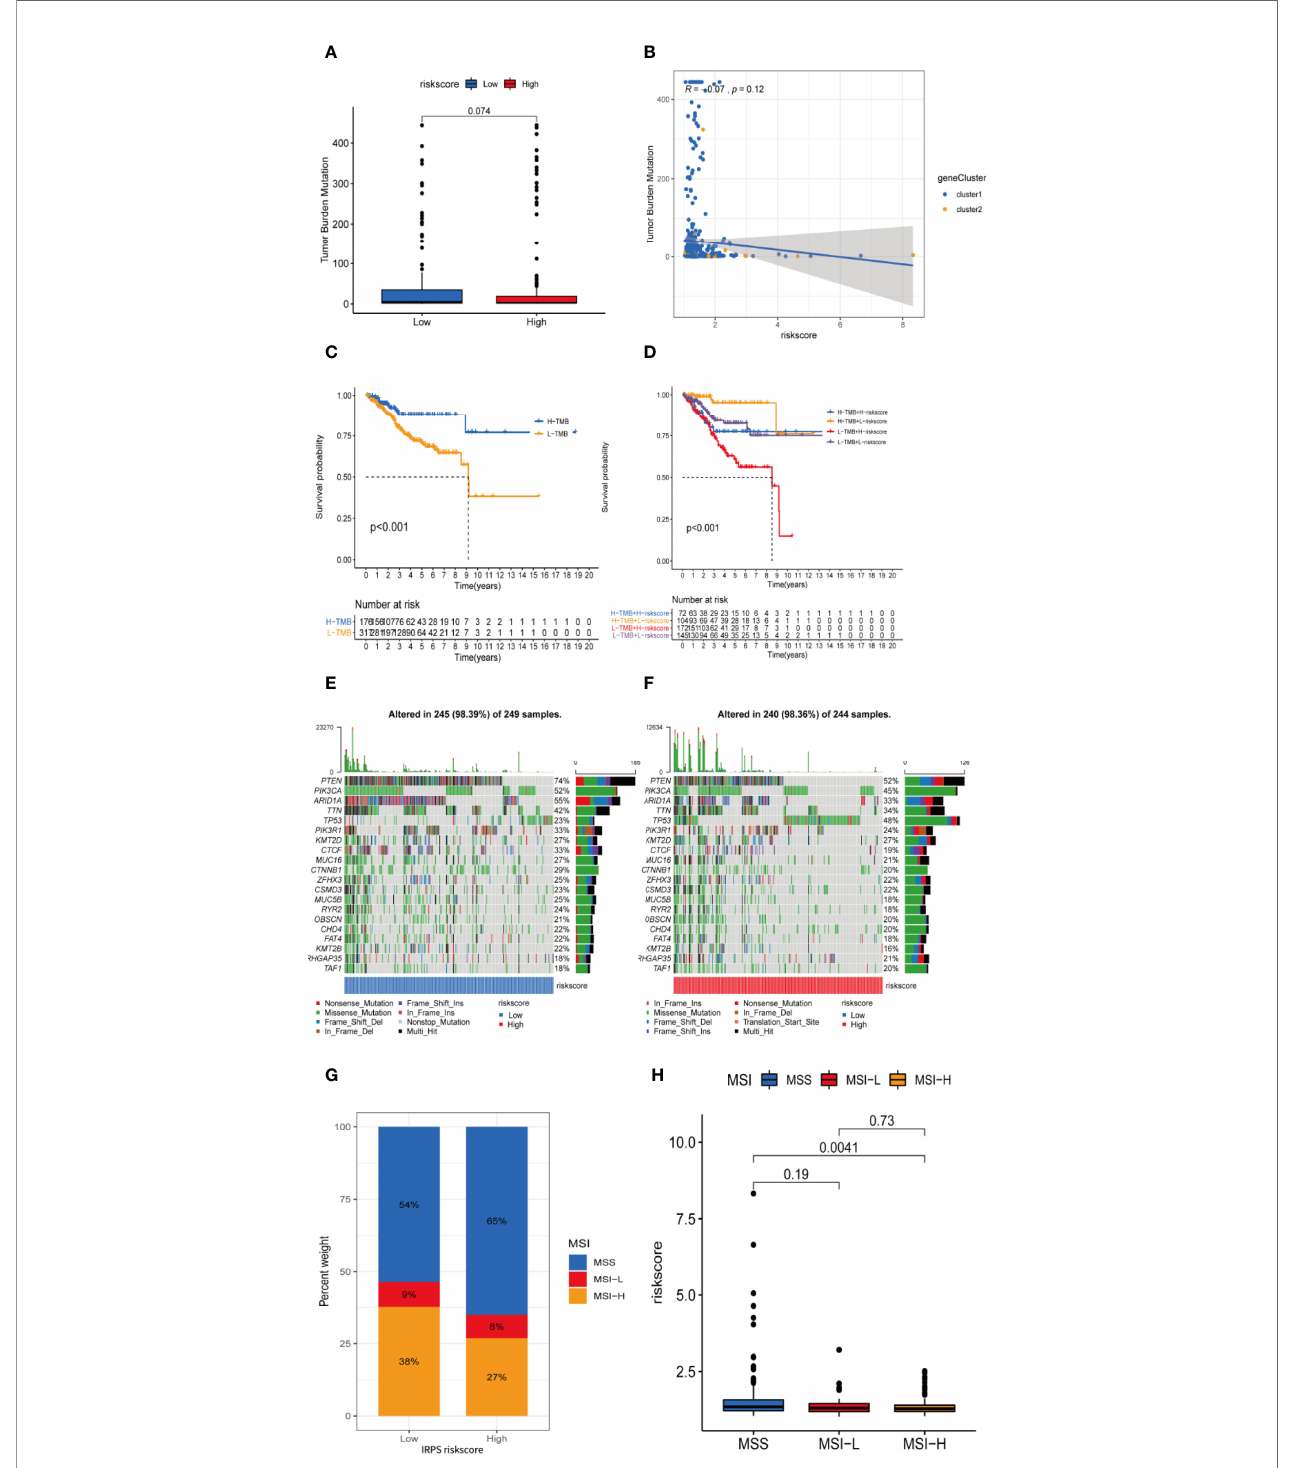
FIGURE 10 | TMB and microsatellite instability are negatively correlated to IRLPS risk score, and can contribute to more signi fi cant prognostic discrimination combined with risk score. (A) Boxplot shows higher TMB in the low-risk group. (B) Correlation analysis implies TMB is potentially negatively related to IRLPS risk score. (C) Kaplan-Meier analysis indicates unfavorable outcome for low TMB patients. (D) Patients with lower TMB and higher risk score have signi fi cantly more pessimistic outcomes. (E, F) Mutation pro fi le in (E) low and (F) high risk score groups. (G) IRLPS high-risk group has higher proportion of MSS and lower